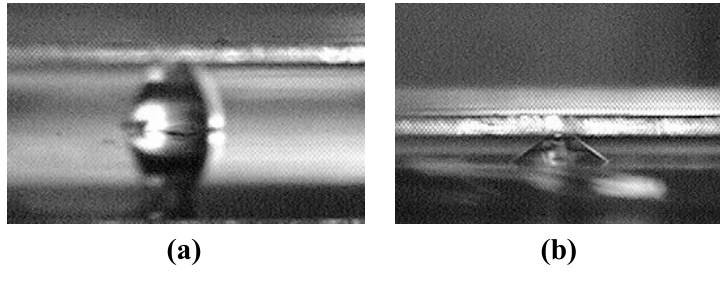
Figure 1. Comparison between the rupture distances of liquid bridges defined by ( a ) microchannels and ( b ) discrete hydrophilic patterns.